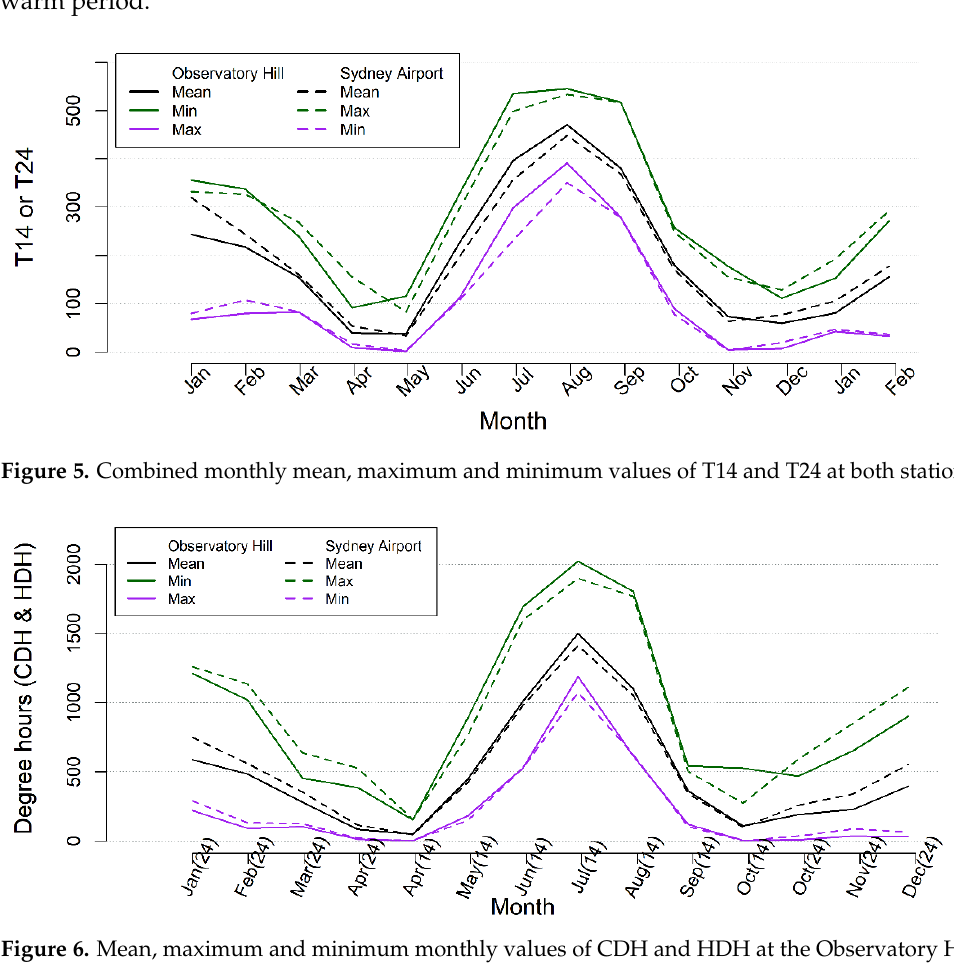
Figure 6. Mean, maximum and minimum monthly values of CDH and HDH at the Observatory Hill and Sydney airport stations for the period 1999 – 2018.